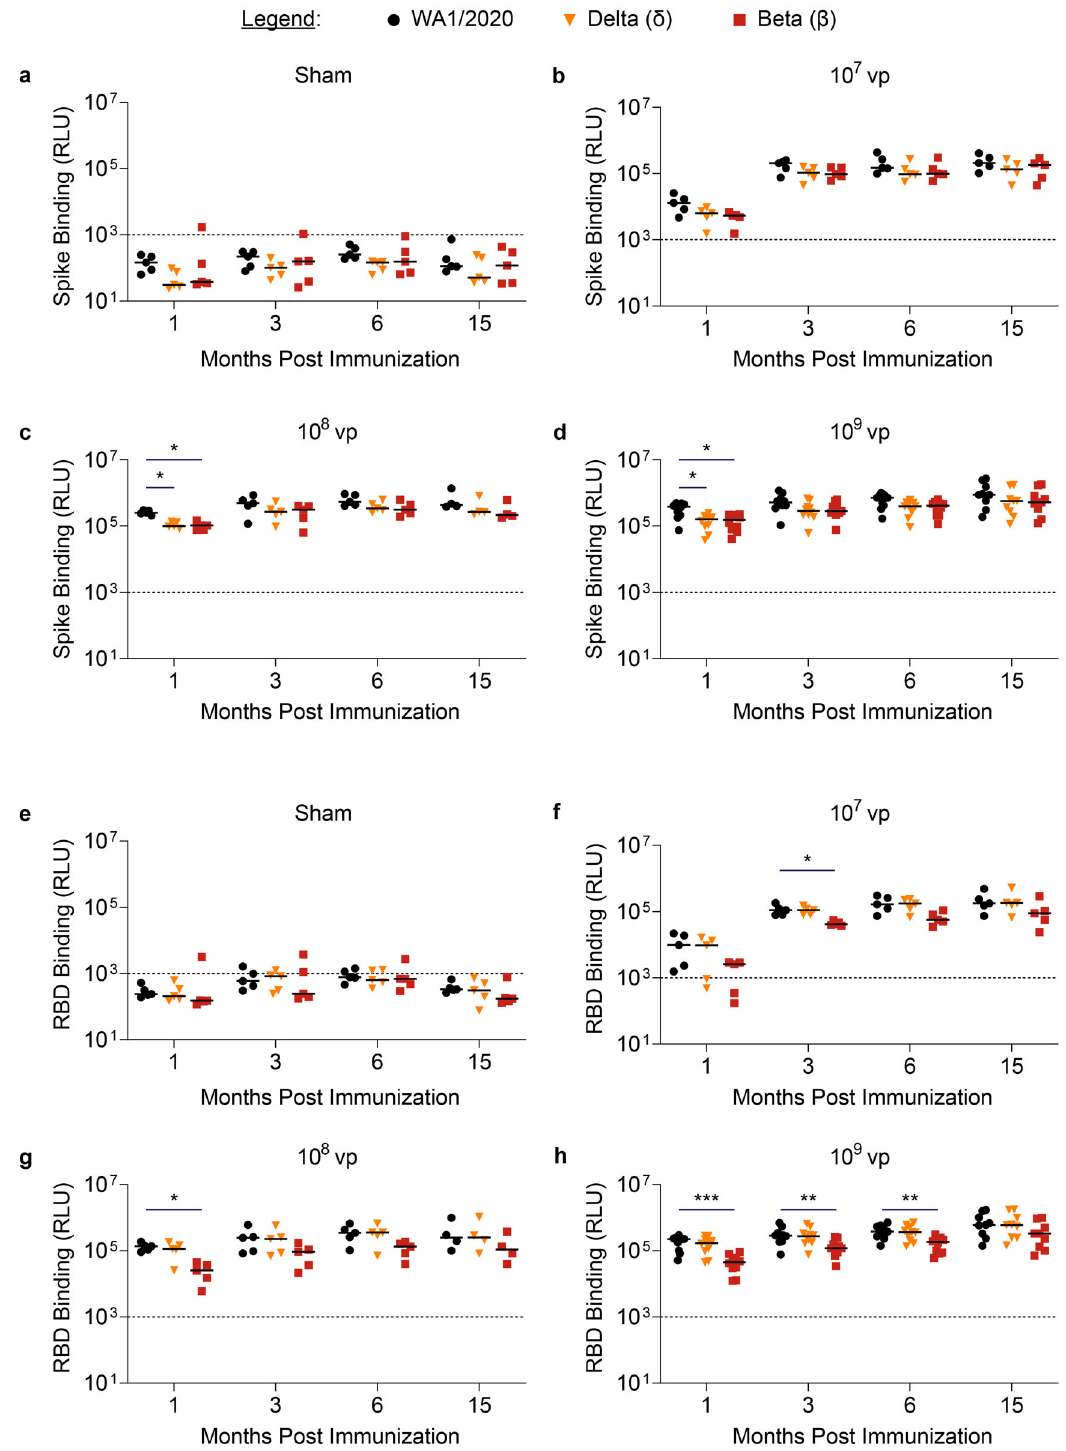
Fig. 2 Binding antibody responses to variants expand in Ad26.COV2.S vaccinated mice. Spike-speci fi c binding antibody responses to WA1/ 2020 (black circles), delta (yellow triangles), and beta variants (red squares) were assessed by electrochemiluminescence assays at months 1, 3, 6, and 15 postimmunization in ( a ) Sham-immunized ( N = 5) or ( b ) 1 × 10 7 vp ( N = 5) ( c ) 1 × 10 8 vp ( N = 5) and ( d ) 1 × 10 9 vp ( N = 10) Ad26. COV2.S immunized mice. Similarly, receptor binding domain (RBD)-speci fi c binding antibody responses to WA1/2020, delta, and beta variants were assessed by electrochemiluminescence assays at months 1, 3, 6, and 15 postimmunization in ( e ) Sham-immunized ( N = 5) or ( f ) 1 × 10 7 vp ( N = 5) ( g ) 1 × 10 8 vp ( N = 5) and ( h ) 1 × 10 9 vp ( N = 10) Ad26.COV2.S immunized mice. Horizontal bars re fl ect median binding values. Dotted lines re fl ect assay limit of quanti fi cation. P values re fl ect Kruskal Wallis tests with Dunn ’ s multiple comparisons, which were conducted separately for each dose and timepoint (* P < 0.05; ** P < 0.01; *** P <